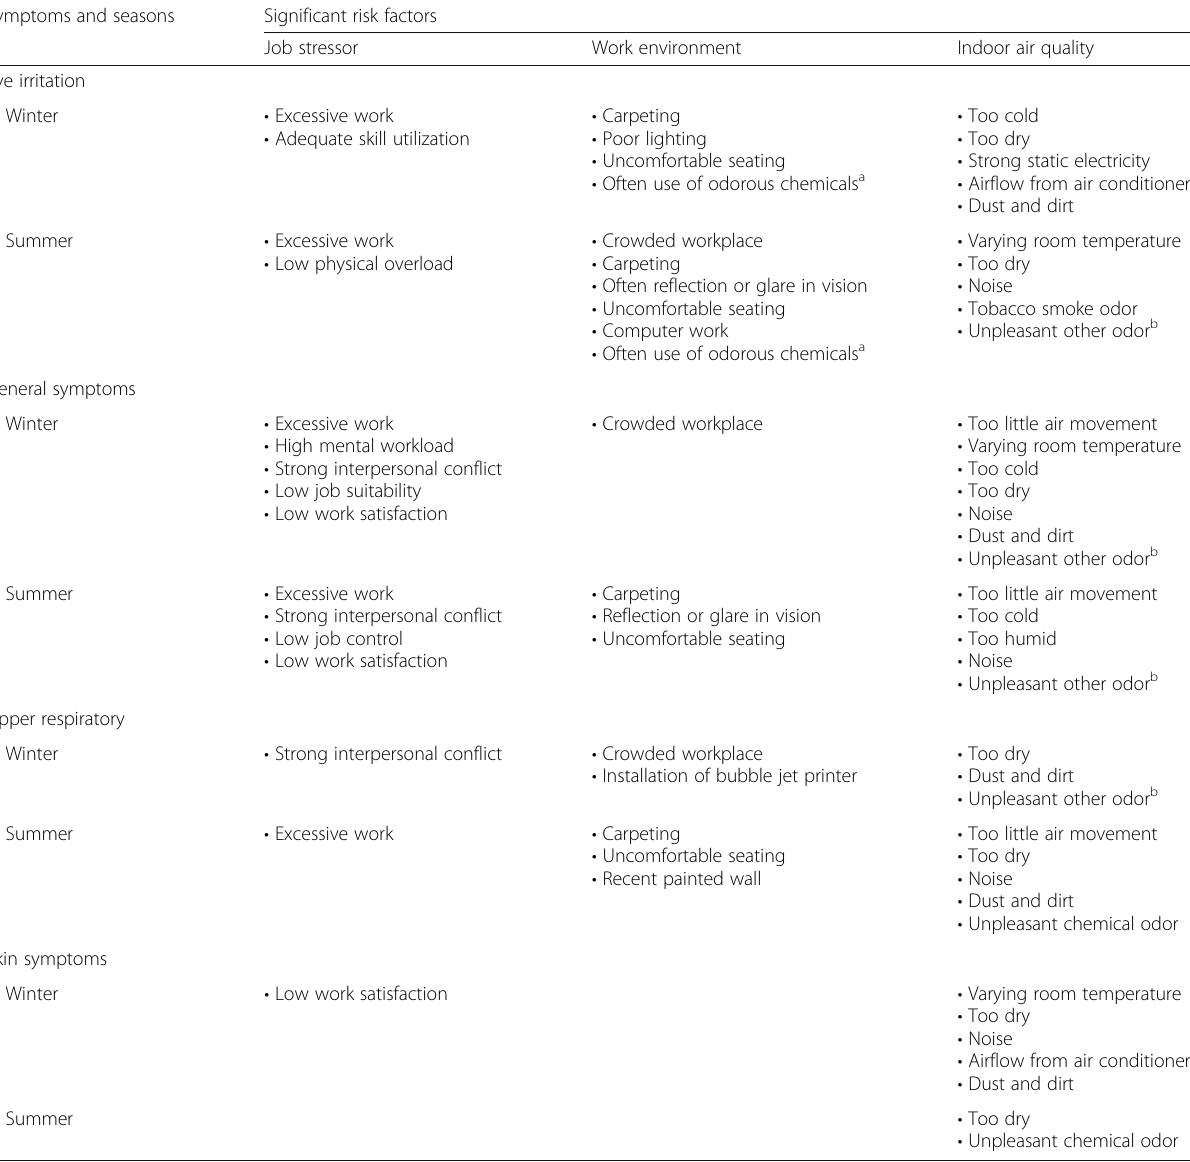
Table 8 Significant risk factors associated with weekly building-related symptoms in final model in winter ( N = 3335) and summer ( N = 3024) Symptoms and